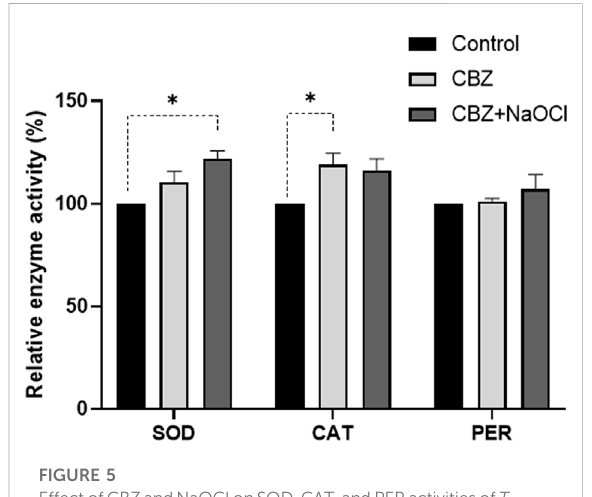
FIGURE 5 EffectofCBZandNaOClonSOD,CAT,andPERactivitiesof T.